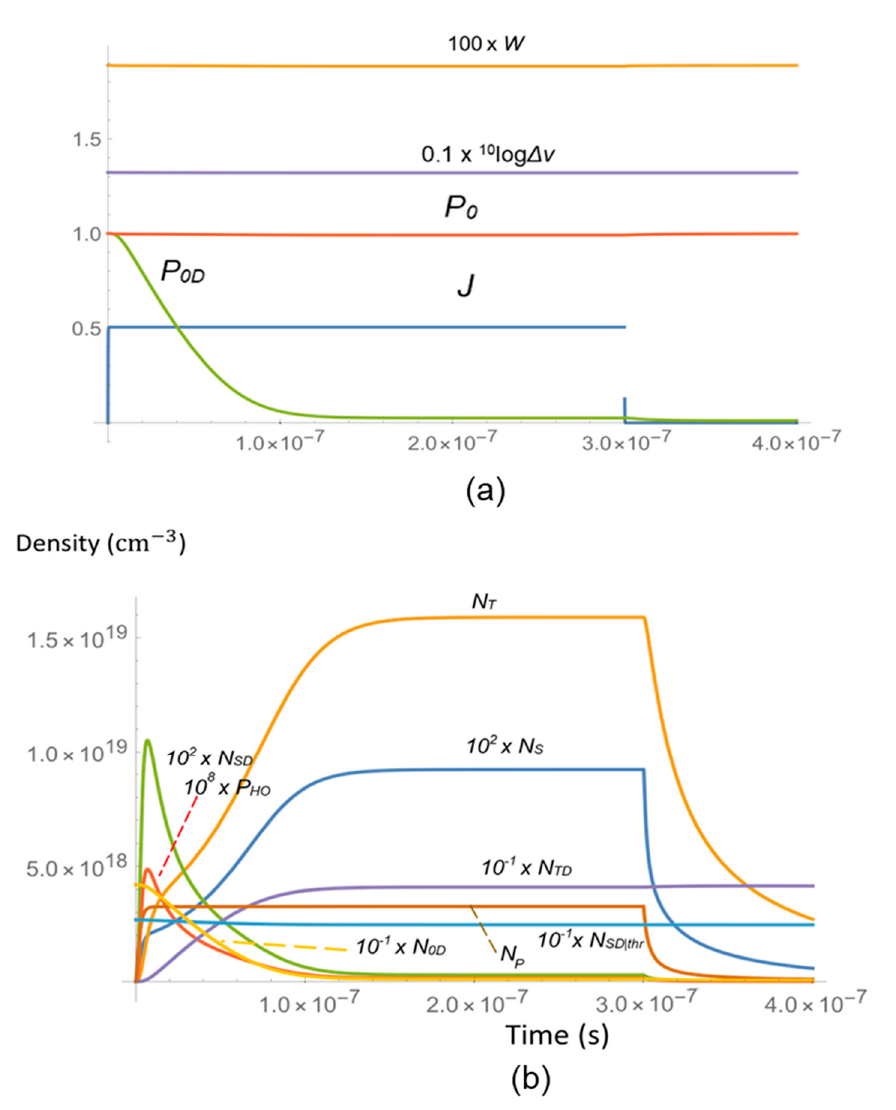
Figure 2. Time evolutions of various quantities for an OLED far below the threshold for lasing. The applied injection current has amplitude 0.5 kA/cm 2 , and a duration of 300 ns. There is no special cavity arrangement assumed; κ CAV = 1 × 10 14 s − 1 , corresponding to Q ∼ = 18, γ = 1 × 10 − 10 cm 3 s − 1 , = 0.05, κ = 2 × 10 8 s − 1 , κ = 6.5 × 10 2 s − 1 , κ = 2.2 × 10 4 s − 1 . ( a ) Current density J in kA/cm 2 , ground-state probabilities P 0 and P 0 D respectively for host and dopant molecules and the linewidth ∆ υ of the emitted light. ( b ) Polaron density N P , exciton densities for host and dopant molecules and the photon density P HO . The light blue curve is 10 − 1 × N SD | thr (see (11); clearly, the maximum of N SD (~ 10 17 cm − 3 ) is far below the threshold value (~2.5 × 10 19 cm − 3 ) .